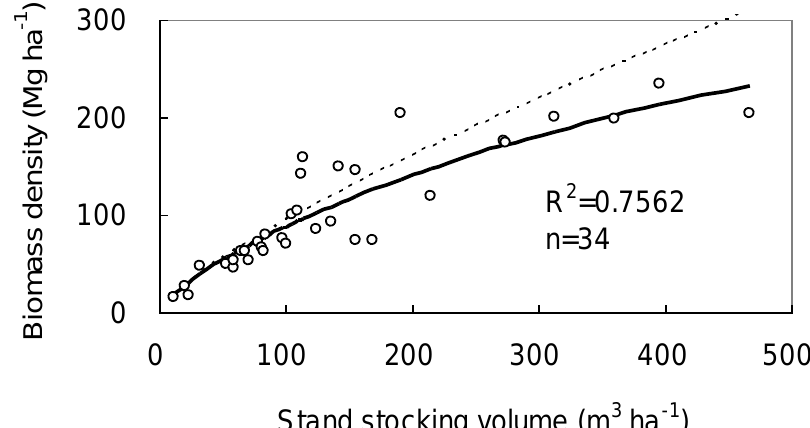
Figure 3. Stand stocking volume versus stand biomass density for parameterizing the volume-to-biomass equation y = r x k e − u x . The parameters estimated by nonlinear regression were r = 2.7468, k = 0.7623 and u = 0.000536 (m − 3 ha) for Pinus yunnanensis . The fine dotted line is a conventional power-law curve (y = r x k , r = 2.6526, k = 0.7742, R 2 = 0.7428). Under the condition of the Jensen inequality 0 ≤ x ≤ ( k + k )/ u , the range of x must be 0 ≤ x ≤ 3051 (m −3 ha). In practice, x is not greater than 500 (m − 3 ha). The condition is met. Table 2. A case study of biomass estimation for Pinus yunnanensis at the provincial scale. Forest Age Groups Sum or Ave. Unit Young Middle Near-Mature Mature Over-Mature